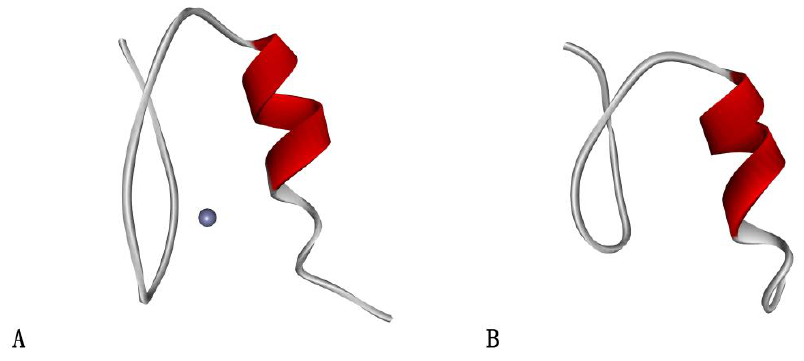
Figure 1. ( A ) Ribbon representation of the main-chain fold of Sp1f2 (PDB code: 1sp2); ( B ) Ribbon representation of the main-chain fold of FSD-1 (PDB code: